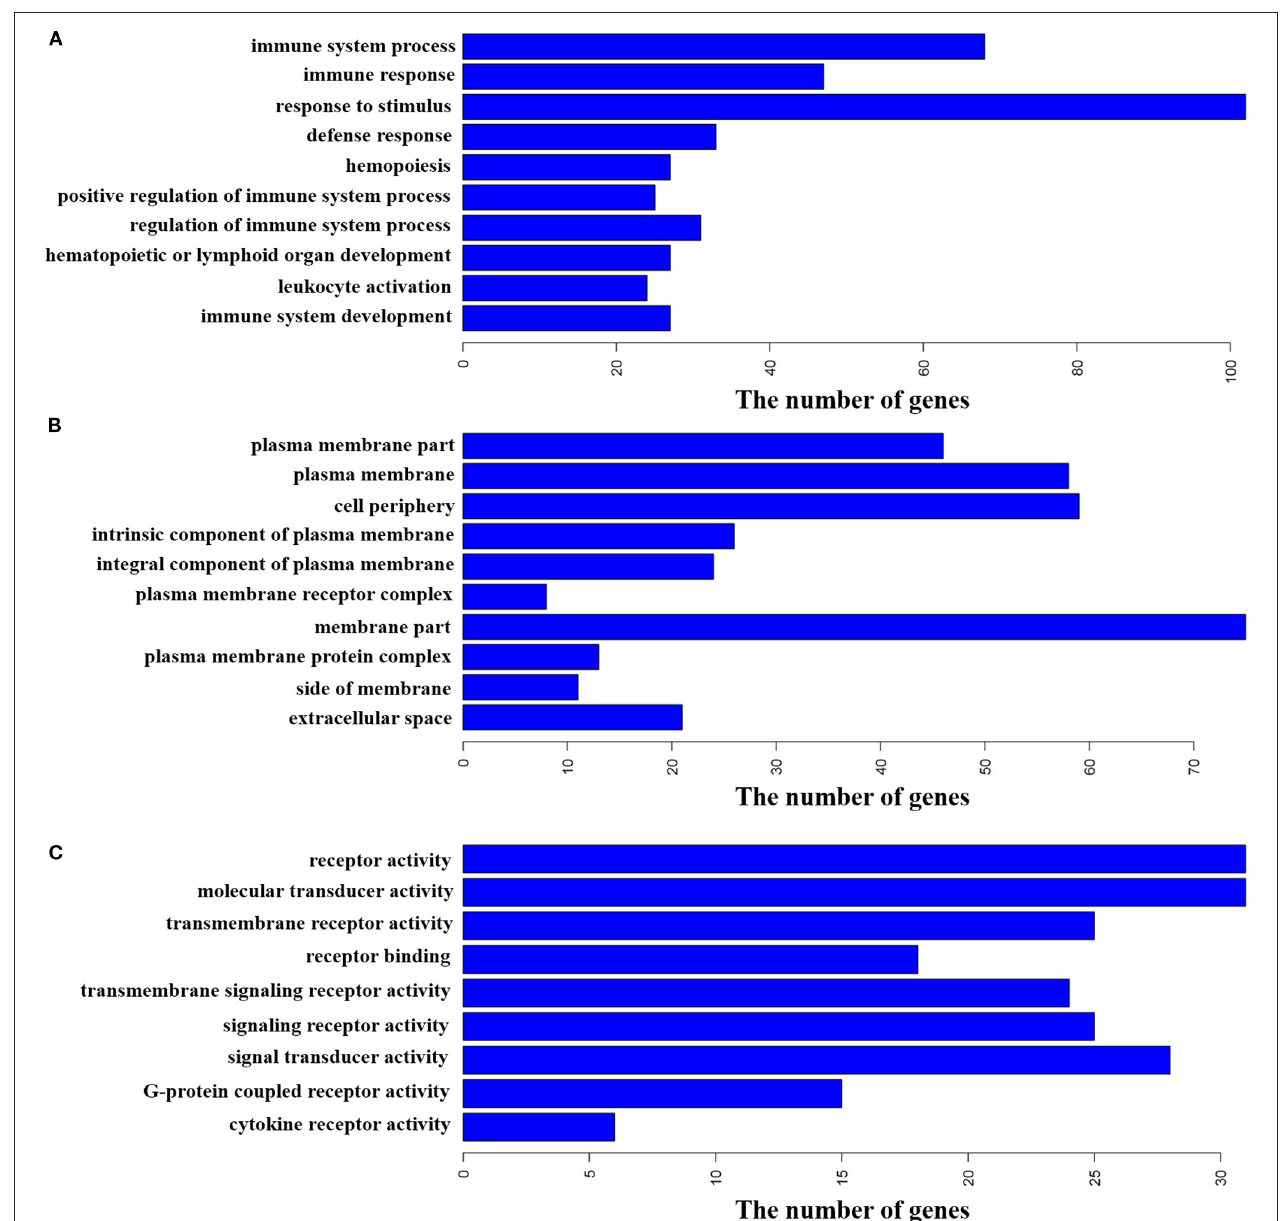
FIGURE 4 | Functional annotation of DEGs by gene ontology (GO) analysis. The bar plot represents the gene counts within each GO category. All function or process terms listed have enrichment of FDR < 0.05. (A) Biological process (top 10). (B) Cellular component (top 10). (C) Molecular